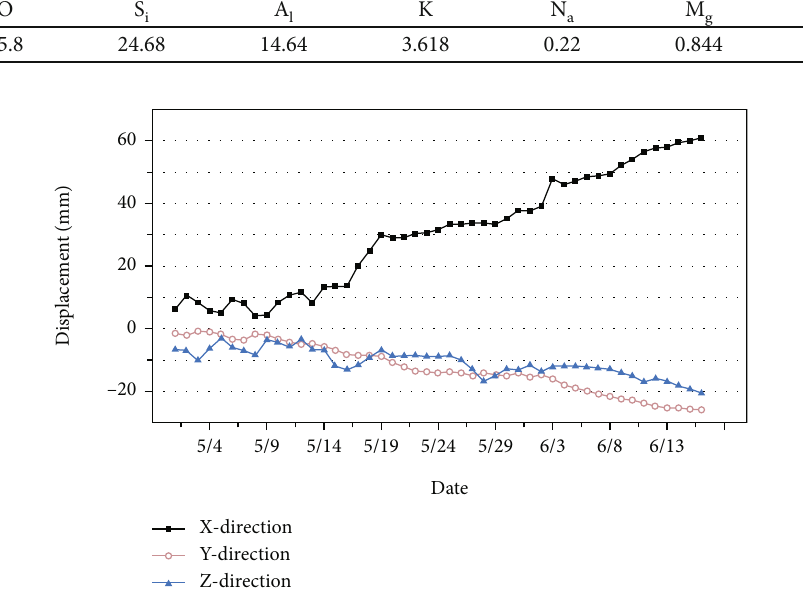
Figure 3: Slope surface displacement ( K40 + 674 ~ K40 + 748